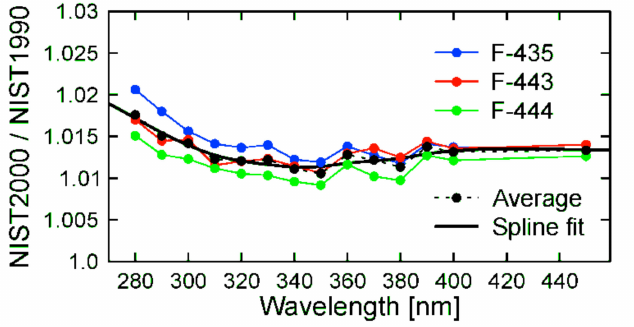
Figure A1. Ratio of spectral irradiance assigned to lamps F-435, F-443, and F-444 according to the SoSI of NIST2000 and NIST1990. The average of the three ratios is indicated by a broken black line. The heavy black line is a fit to this average using an approximating spline. This function was used to scale the SoSI of the four CUCF lamps from NIST2000 to